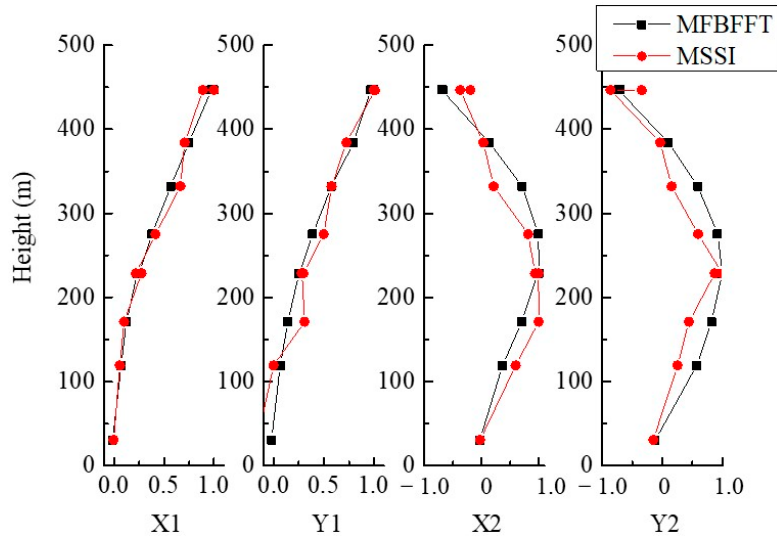
Figure 17. Comparison of the identified mode shapes of the Canton Tower.